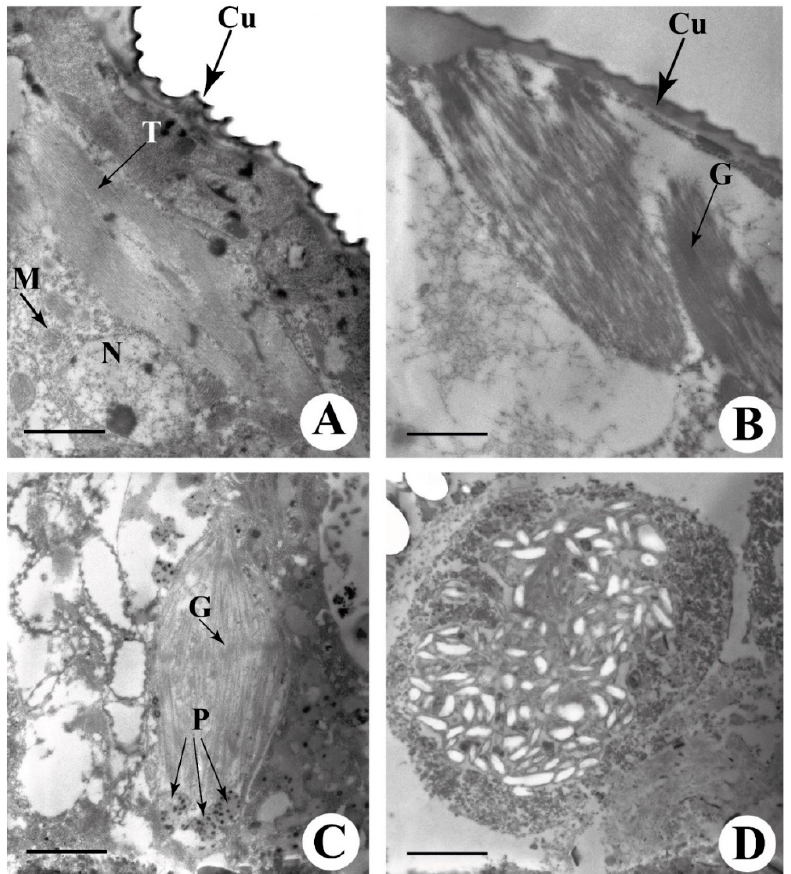
Figure 2. Transmission electron microscopy of TSSM. ( A ) ultrathin section of a TSSM showing the presence of the mite cuticle (Cu), a chloroplast showing the thylakoids (T), mitochondria (M), and a nucleus (N). ( B ) ultrathin section of a TSSM showing the presence of the mite cuticle (Cu) and the grana (G) stacks of a chloroplast. ( C ) ultrathin section of a TSSM showing a chloroplast with evident grana (G) stacks and the presence of some plastoglobules (P). ( D ) ultrathin section of a TSSM showing the ultrastructure of one of the red fluorescent bodies indicated by the double arrow in Figure 1C,D. Metric bars, A = 1.57 µ m; B, C = 1.02 µ m; D = 3.46 µ